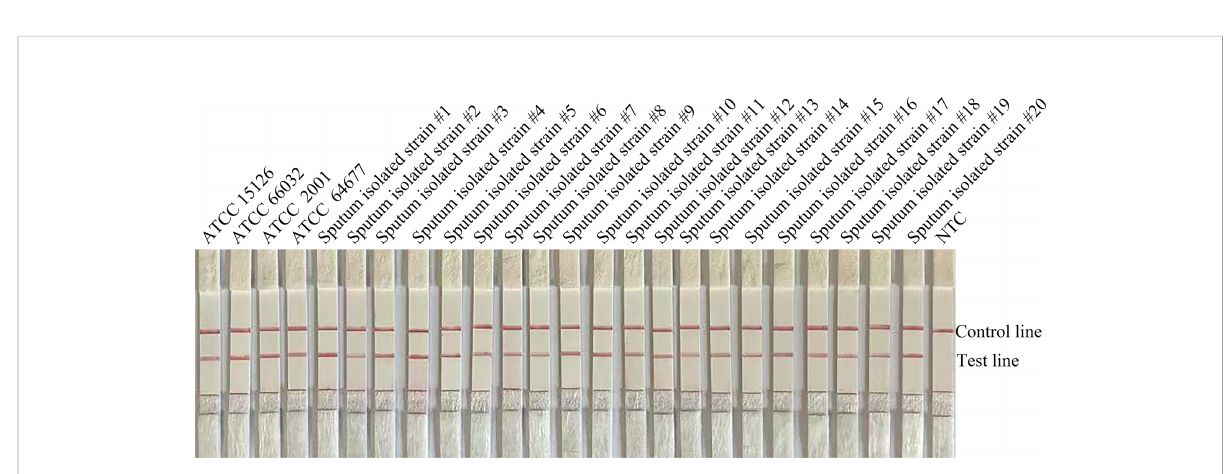
FIGURE 3 Validation of primer pair F4/R2/P speci fi city against C. glabrata . (A) #1 – #20 are the 20 C . glabrata isolated from clinical samples. NTC denotes no- template control. The positions of the test and control lines are marked on the right side of the bar graph. Reactions were performed at 37°C for 20 min. Images represent the results of three independent experiments.